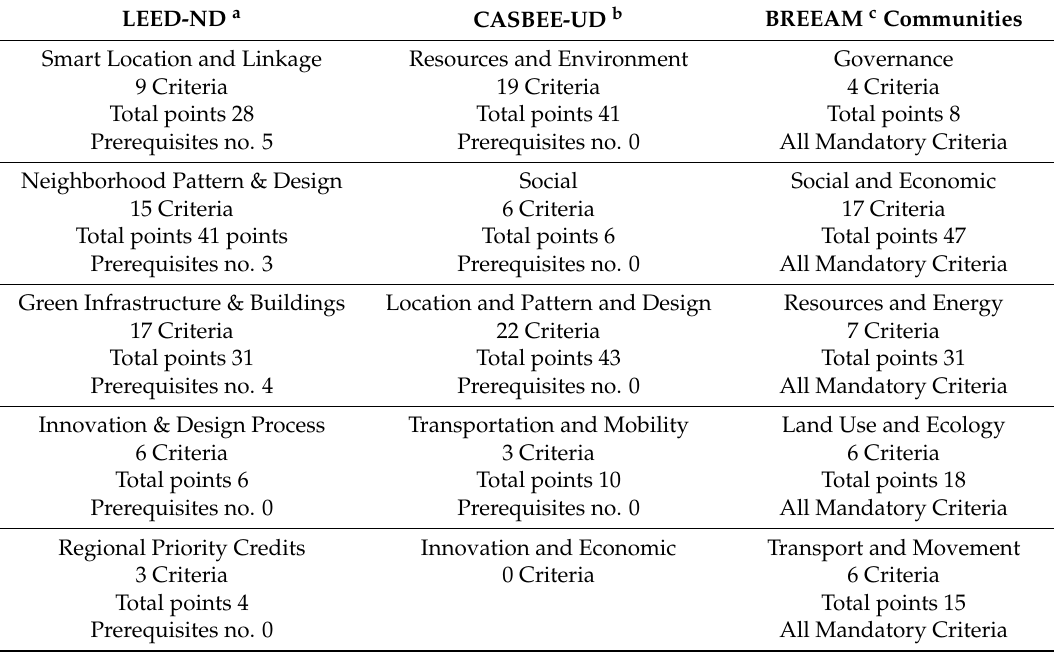
Table 1. Breakdown of evaluation tool credit